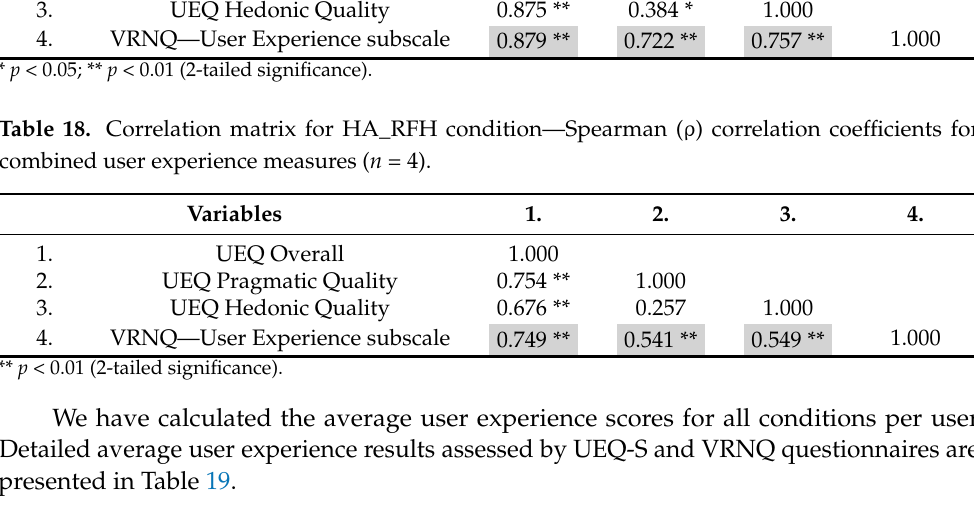
Table 19. Subjective average user experience scores assessed by UEQ-S and VRNQ (User Experience Section)